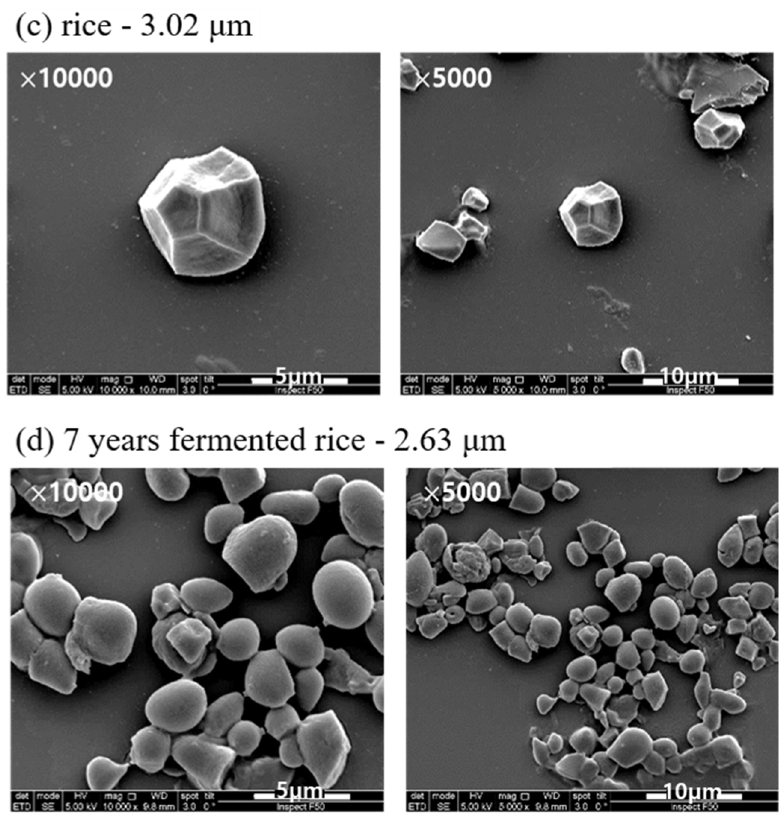
Figure 3. SEM micrographs of: ( a ) fresh wheat starch; ( b ) 5-year fermented wheat starch; ( c ) fresh rice starch; and ( d ) 7-year fermented rice starch granules.